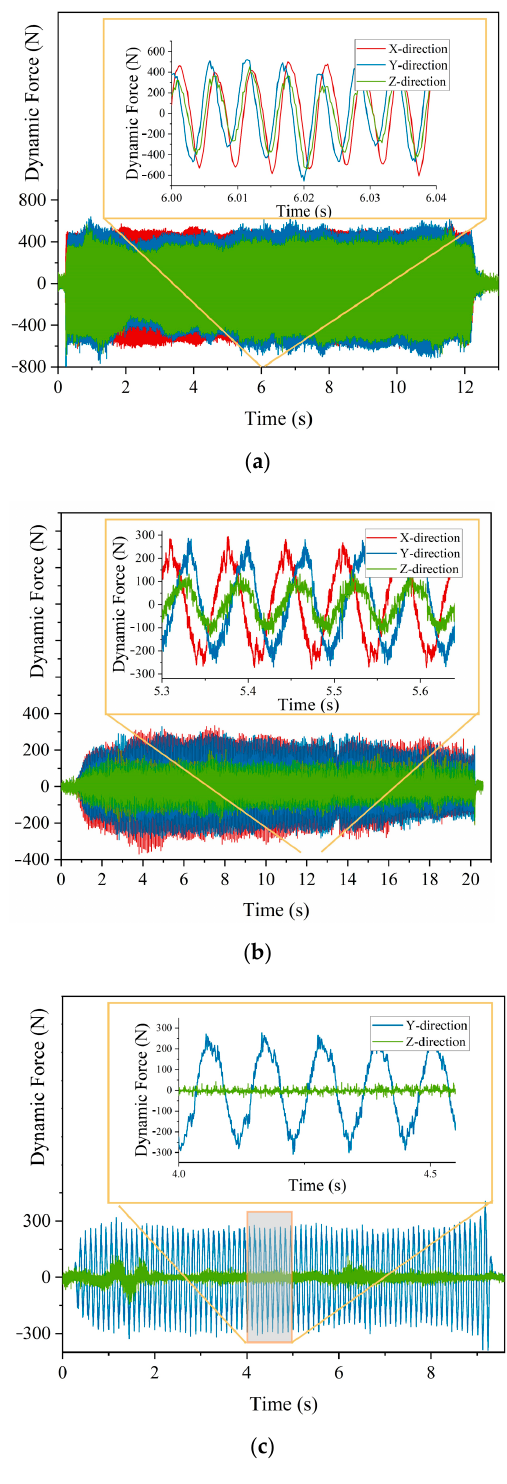
Figure 10. Measured time-domain cutting force. ( a ) Milling load amplitude and frequency spectrum. Tungsten steel body tool, 4 inserts, 10 mm diameter cutter, n f = 2700 r/min, v f = 200 mm/min, a p = 3 mm. ( b ) Drilling load amplitude and frequency spectrum. Arbide tool, 2 inserts, 16 mm diam- eter cutter − 8 mm guide hole, n f = 900 r/min, v f = 60 mm/min, a p = 4 mm. ( c ) Boring load ampli- tude and frequency spectrum. Carbide tool, Single insert, Bore, Diameter-34 mm, n f = 540 r/min, v f = 60 mm/min, a p = 1.5